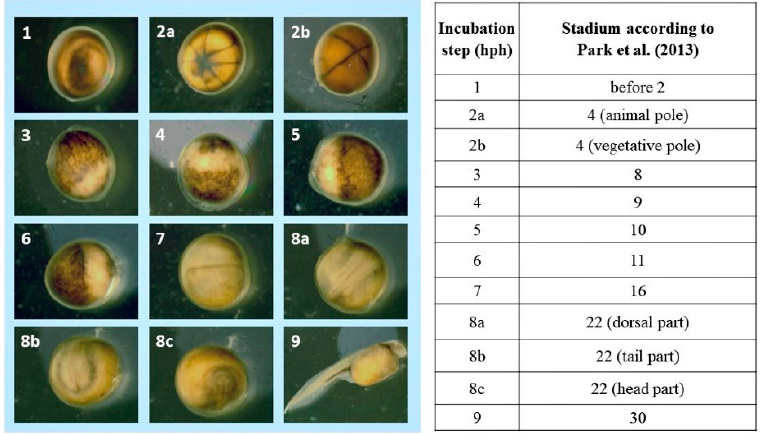
Figure 3. Embryonic development of Siberian sturgeon ( ♀ Siberian sturgeon × ♂ Siberian) offspring (group C—control) according to Park et al. [10].